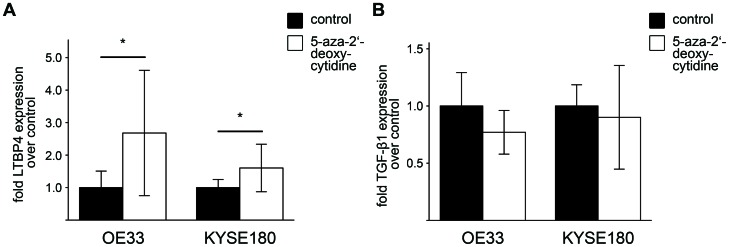
Demethylation treatment with 5-aza-2’-deoxycytidine induces LTBP4 expression, whereas TGF-β1 expression is not changed.A) qPCR analysis showed induction of LTBP4 expression in OE33 and KYSE180 cells after demethylation treatment with 5-aza-2’-deoxycytidine. B) qPCR analysis showed no significant changes in TGF-β1 expression in OE33 and KYSE180 cells after demethylation treatment with 5-aza-2’-deoxycytidine. Untreated cells served as control. Experiments were repeated at least 3 times and the mean value was calculated. Data are presented ± standard deviation and *p<0.05 versus control.